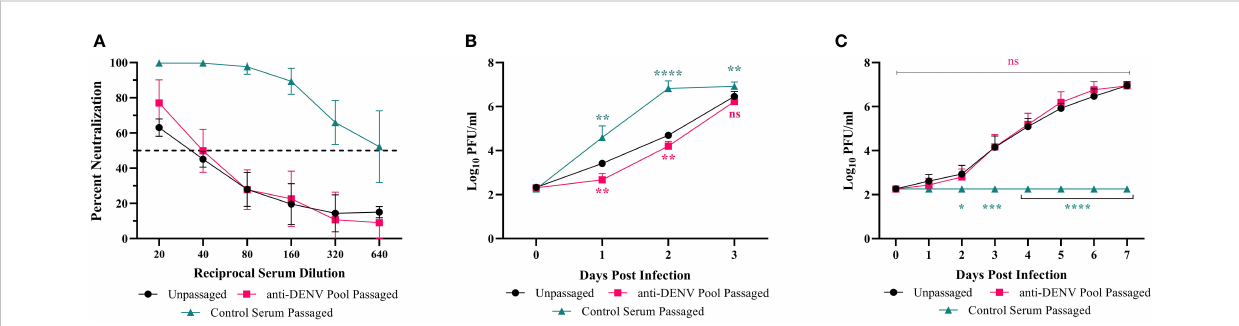
FIGURE 5 Neutralization dynamics and replicative fi tness of passaged populations. WT ZIKV (black line), passage 5 of the anti-DENV pool passaged population (red lines), or passage 5 of the Control Serum-passaged population (green lines) were tested for neutralization sensitivity and replication. Data are from two biological replicates, each with three technical replicates, and the error bars represent the standard deviation from the mean. (A) The anti- DENV serum pool was serially diluted and mixed with 800 PFU/mL of each virus, and percent neutralization was recorded at each dilution. (B, C) Vero cells were either infected at an MOI of .01 with untreated virus (B) or virus incubated with the anti-DENV pool for 1 hour. Statistics were performed using a two-way ANOVA with a Dunnett ’ s correction for multiple comparisons comparing the passaged viruses to the unpassaged virus (ns - nonsigni fi cant, * - p = 0.0139, ** - p = 0.001, *** - p = 0.005, **** - p < 0.0001).